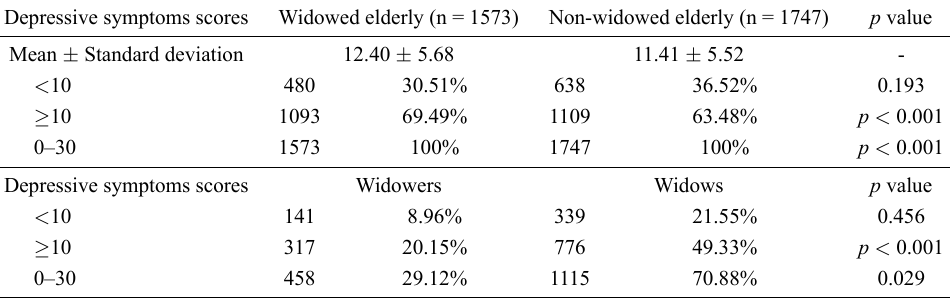
Table 3. Depressive symptoms of the widowed elderly.